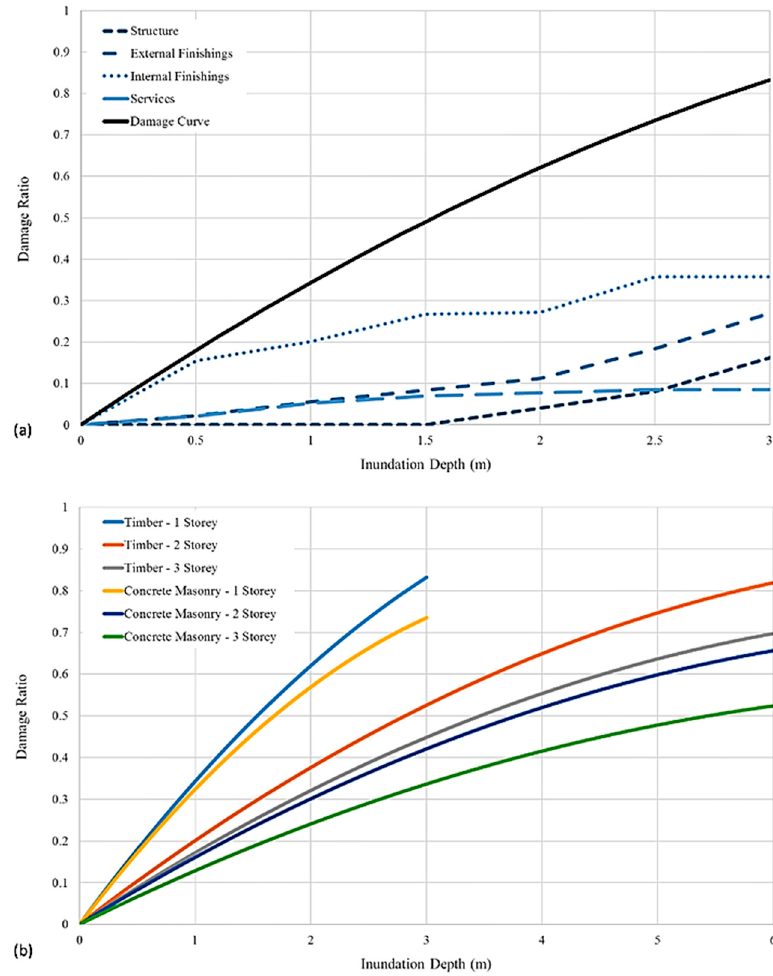
Figure 3. ( a ) ‘Timber—1 Storey’ building class component damage ratios with simplified ‘fitted’ synthetic depth–damage curve. ( b ) Synthetic depth–damage curves representing mean expected damage ratios for timber and concrete masonry building classes at Omaha Beach, New Zealand.